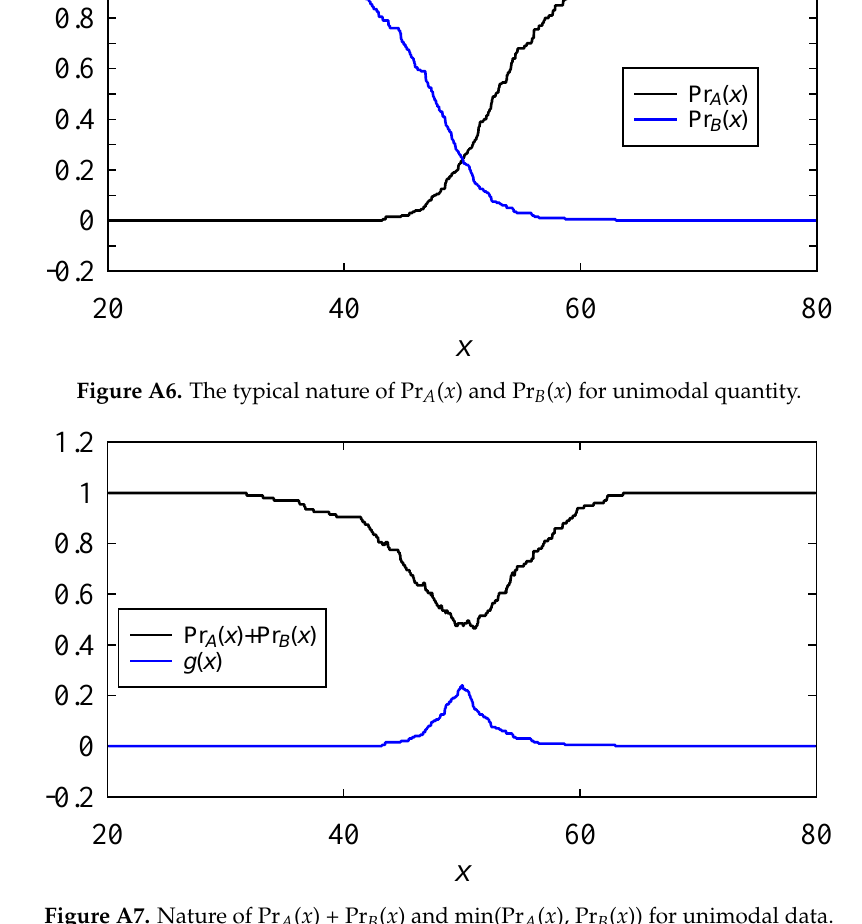
Figure A7. Nature of Pr A ( x ) + Pr B ( x ) and min(Pr A ( x ), Pr B ( x )) for unimodal data.